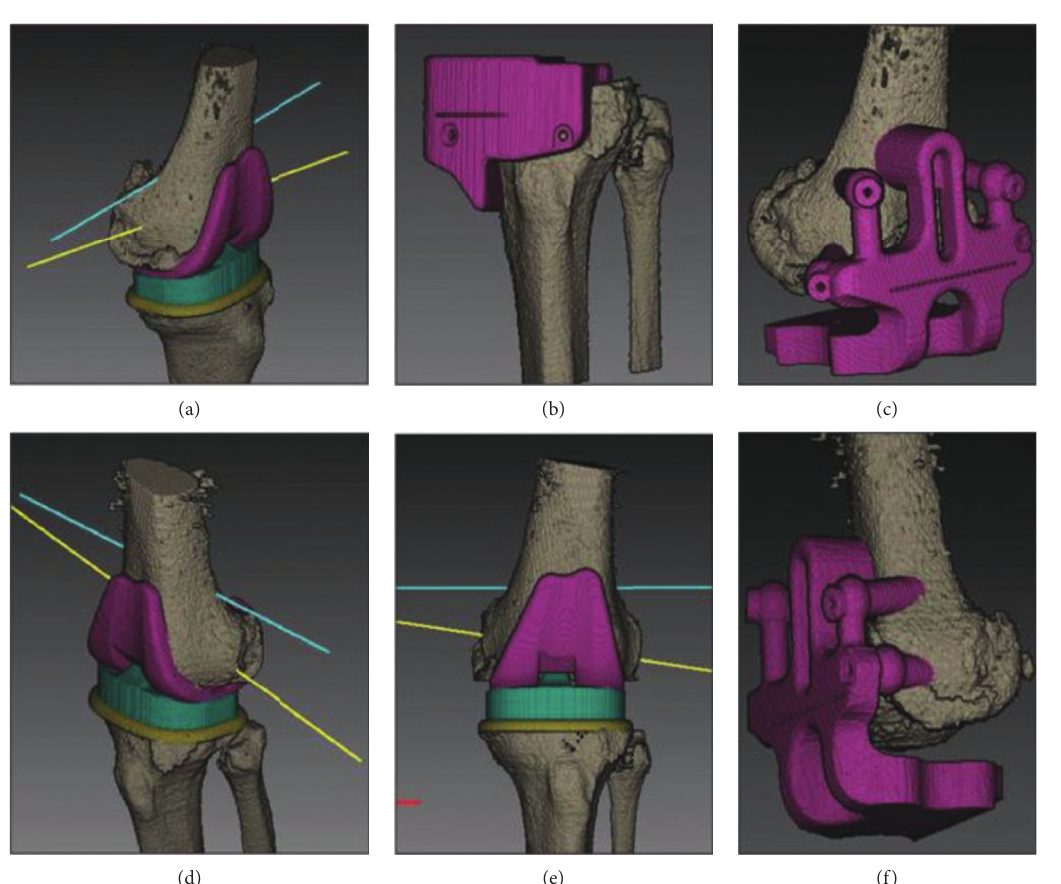
Figure 2: TKA planning showing the sizing, alignment, and implant positioning that matches the patient’s